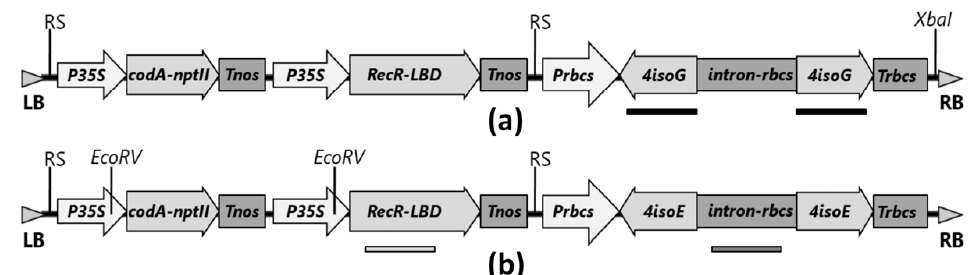
Figure 1. Scheme of the T-DNA region of vectors pMF-R6-iso4G ( a ) and pMF-R6-iso4E ( b ) used for the transformation of rootstock plants. RS, recombination site; RB and LB, right and left border of T-DNA, respectively; P35S, CaMV35S promoter; codA-nptII , translational fusion gene for positive ( nptII ) and negative ( codA ) selection; Tnos, nopaline synthase terminator; RecR-LBD , translational fusion of Recombinase R-LBD; Prbcs, Trbcs, and intron-rbcs, ribulose-(1.5)-bisphosphate carboxy- lase/oxygenase small subunit gene promoter, terminator and intron, respectively; 4isoG , eIF(iso)4G eukaryotic initiation translation factor gene (fragment 0.6 kb); 4isoE, eIF(iso)4E eukaryotic initiation translation factor gene (fragment 0.6 kb). Xba I and Eco RV, position of the restriction sites for which the DNA was digested for the Southern blot assay. Black, dark gray, and gray stripes indicate the place of hybridization of the probes.